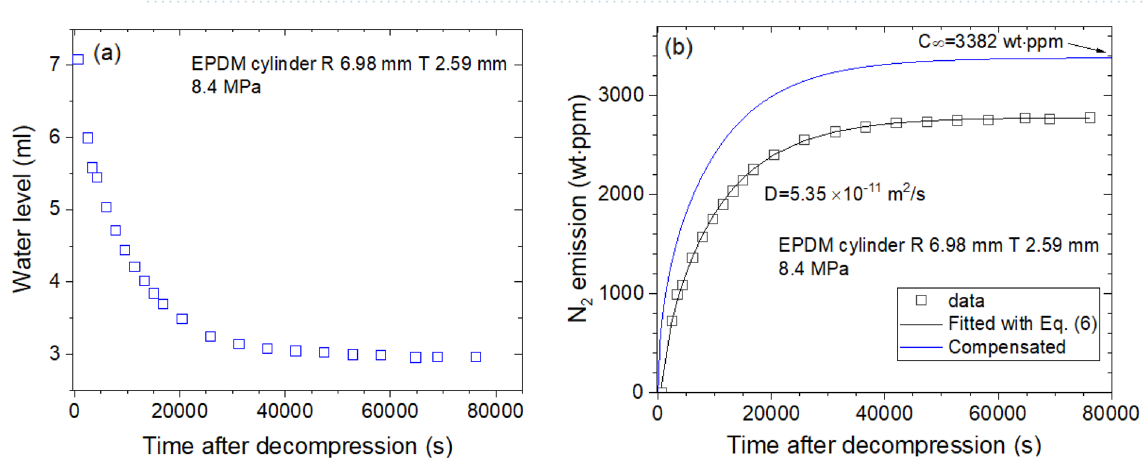
Figure 2. Sequence for obtaining the diffusion parameter in NBR cylindrical rubber. ( a ) Water level versus time after decompression and ( b ) time-varying He mass concentration transformed from the water level. As a result of the experimental investigation, the diffusion parameters D and C ∞ are determined using a diffusion analysis program. The blue line is the total compensated emission curve restoring the missing content for lag time. R and T indicate the radius and thickness, respectively, of the cylindrical specimen.